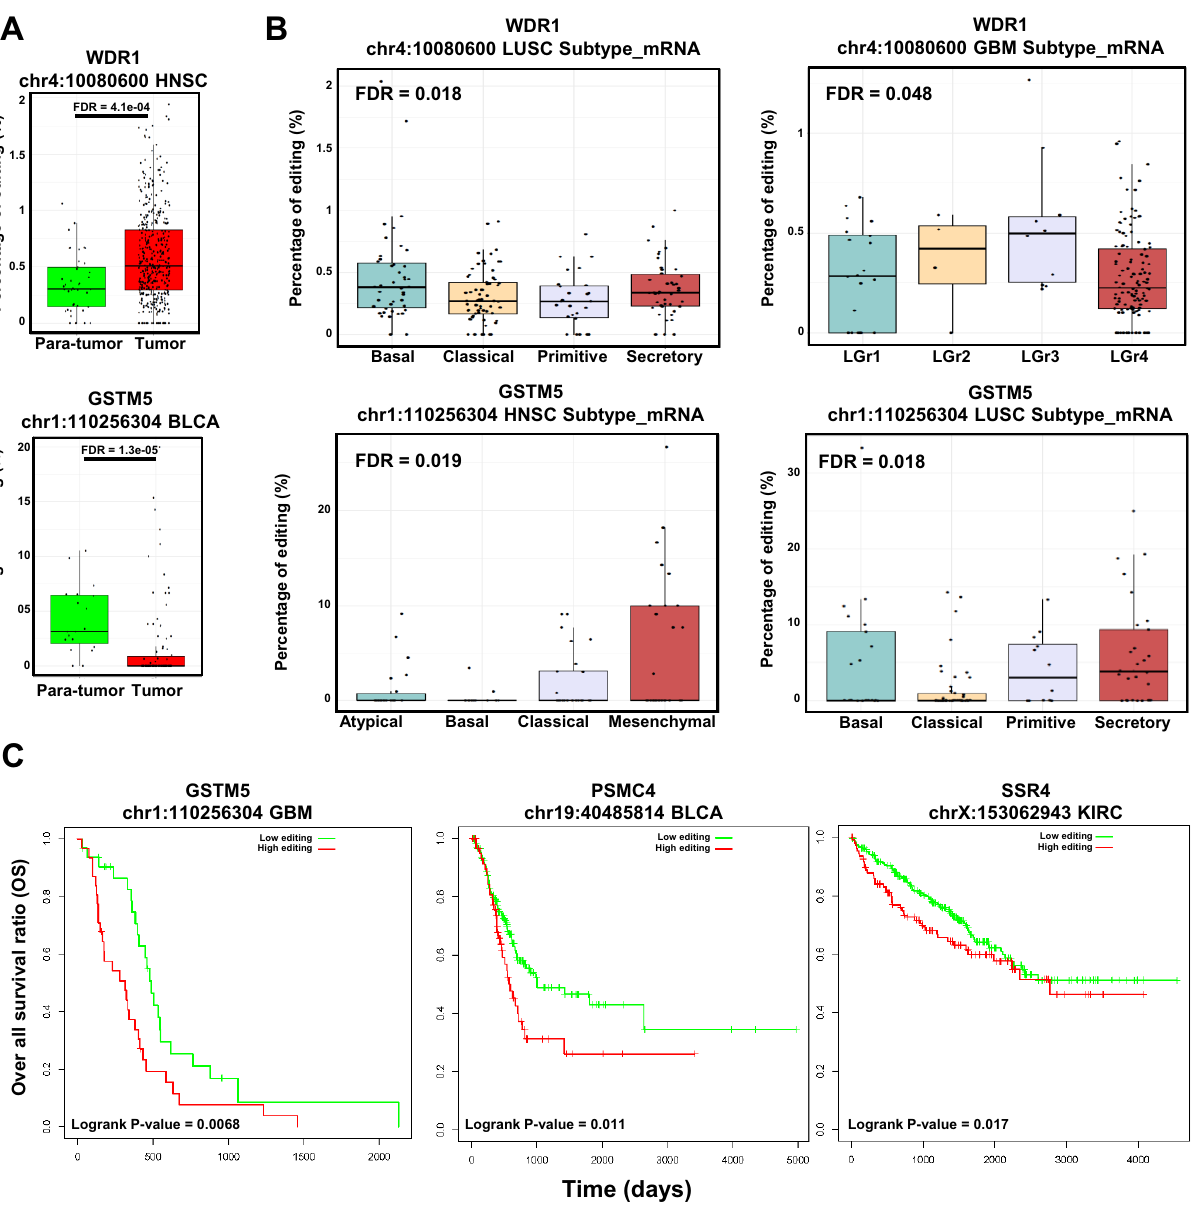
Figure 5. The distribution of nonsynonymous RNA editing on ubiquitination site in TCGA database. ( A ) The boxplot demonstrating the editing level between tumor and para-tumor samples in TCGA dataset. The P-value was computed by “wilcox.test” function in R. ( B ) The boxplot demonstrating the editing level among subtypes in TCGA dataset. The P-value was computed by “aov” function in R. ( C ) The Kaplan–Meier overall survival curves of patients were grouped by the editing level in TCGA database. The high and low editing levels were determined by the median value of editing